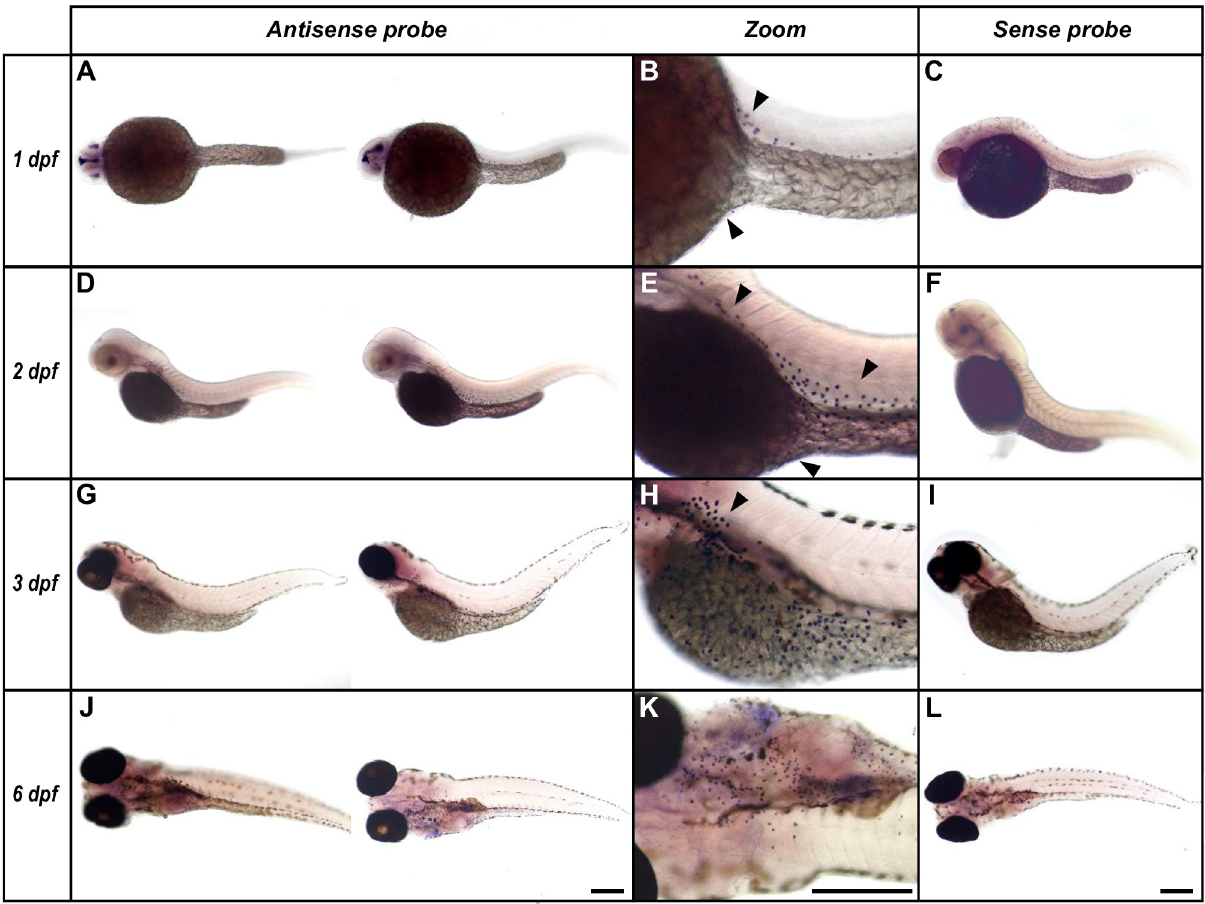
Fig 4. Whole mount in situ hybridization with specific zebrafish ceacamz1 RNA probes. Larvae at 1 dpf (A-C) , 2 dpf (D-F) , 3 dpf (G-I) or 6 dpf (J-L) . Ceacamz1 mRNA signals are detected in discrete cells around the yolk sac and yolk extension readily from 1 dpf stage (as indicated by black arrows). They also appear around the forming gills after 3 dpf stage. Scale bars: 1